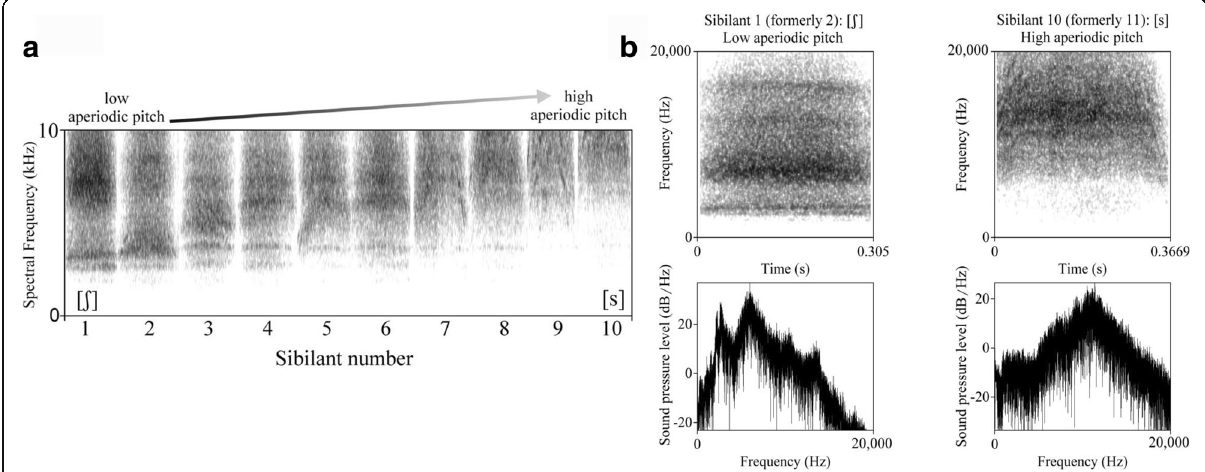
Fig. 4 a Spectral characteristics (0 – 10 kHz) of the ten sibilants in the sibilant continuum from [ ʃ ] to [s] that provides the basis of the stimuli in the main experiment. The sibilants correspond to tokens 3 – 12 of the original sibilant continuum; b more detailed frequency analysis of the two sibilants 1 and 10 (formerly 3 and 12) at the endpoints of the continuum. The upper panel shows spectrograms and the lower panel spectra (0 – 20 kHz) of the two